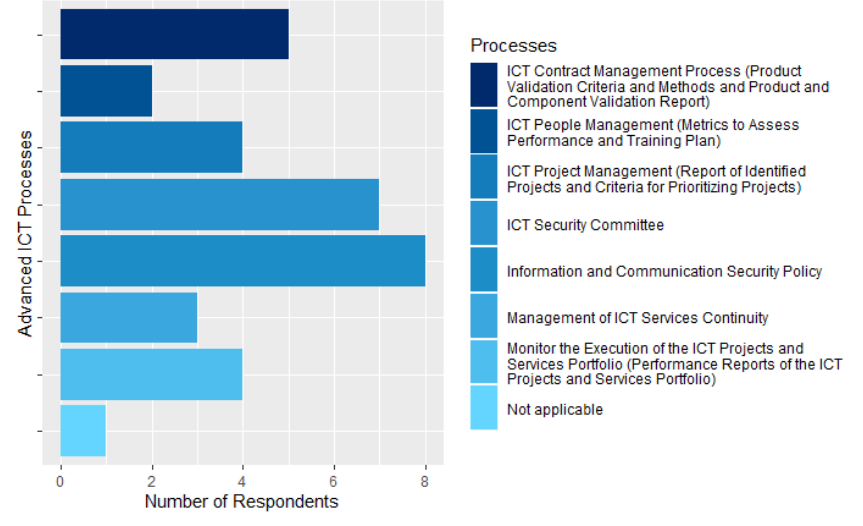
Figure 15. Advanced ICT